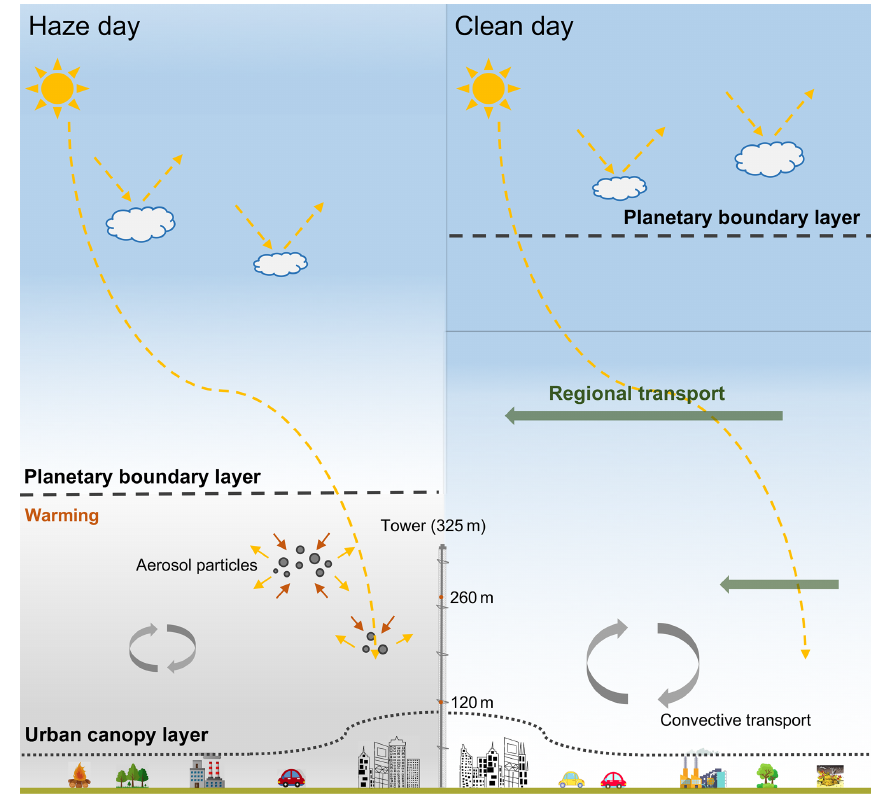
Figure 1. A schematic cartoon showing the atmospheric vertical structure over Beijing on polluted (“haze”) and clean